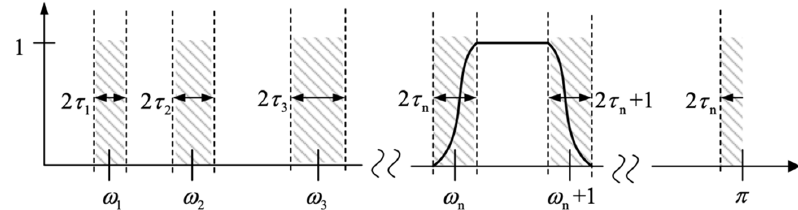
Figure 1. EWT partitioning of the Fourier spectrum axis.